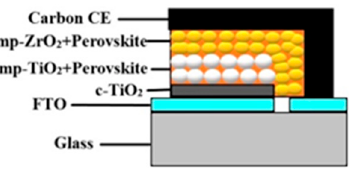
Figure 1. Structure of monolithic hole-transport-material-free (HTM-free) perovskite solar cell